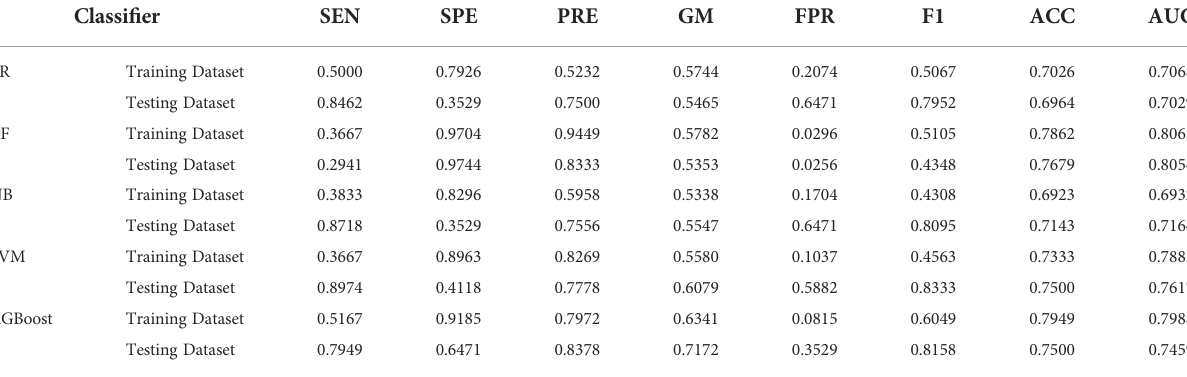
TABLE 3 Evaluation indicators of predictive performance of fi ve models in HER2-overexpressed and Non-HER2-overexpressed groups. Classi fi er